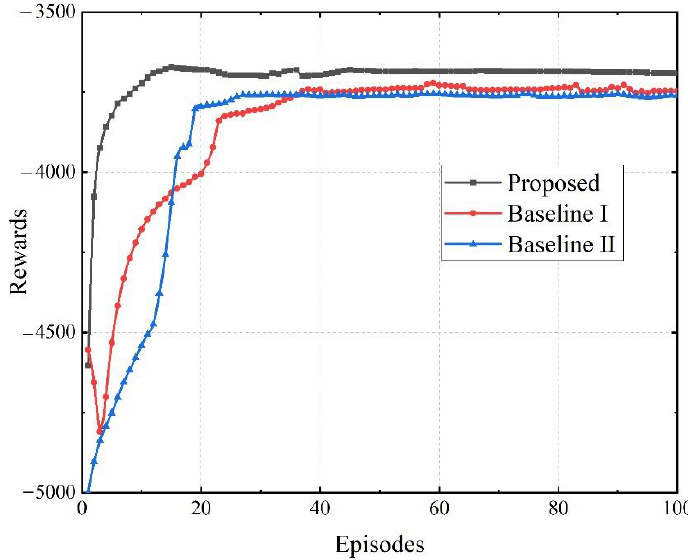
Figure 5. Average reward trajectories in the training process.